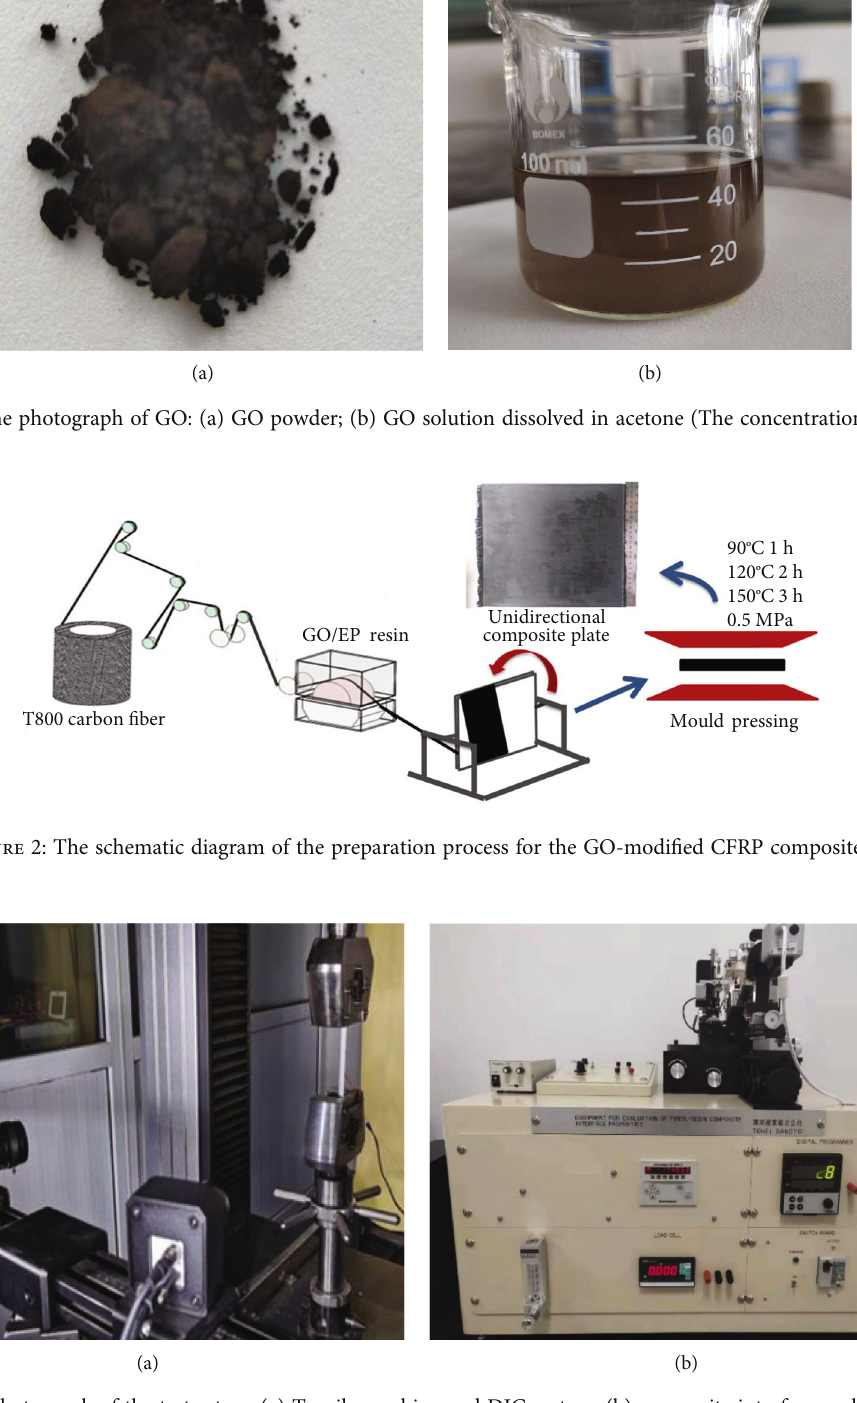
Figure 3: The photograph of the test setups (a) Tensile machine and DIC system; (b) composite interface evaluation